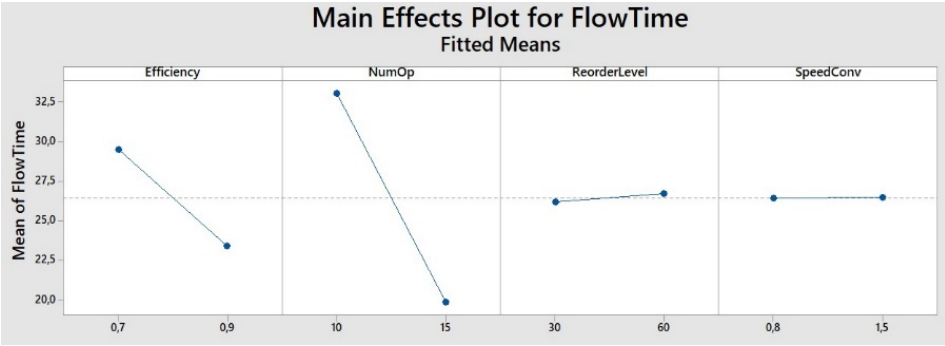
Figure 18. Interaction Plot for Flow Time.